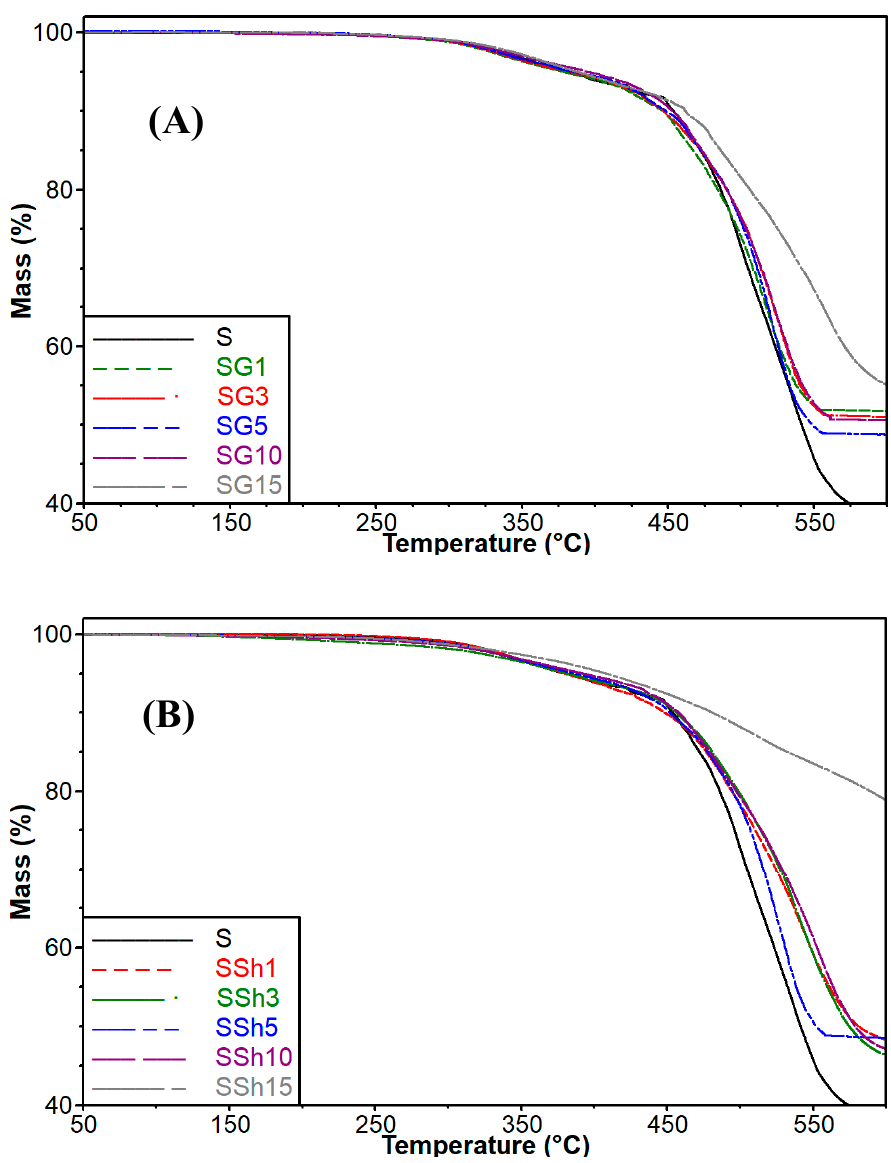
Figure 11. ( A ) Thermogravimetric curves for Sylgard (S) and its composites containing graphite. ( B ) Thermogravimetric curves for Sylgard (S) and its composites containing shungite.